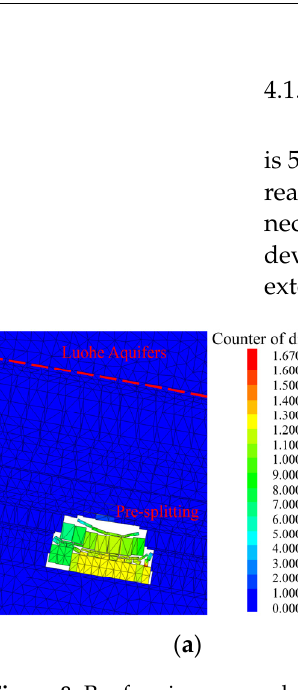
Figure 7. Roof caving process by conventional mining at the length of ( a ) 60 m and ( b ) 70 m, respec- tively.